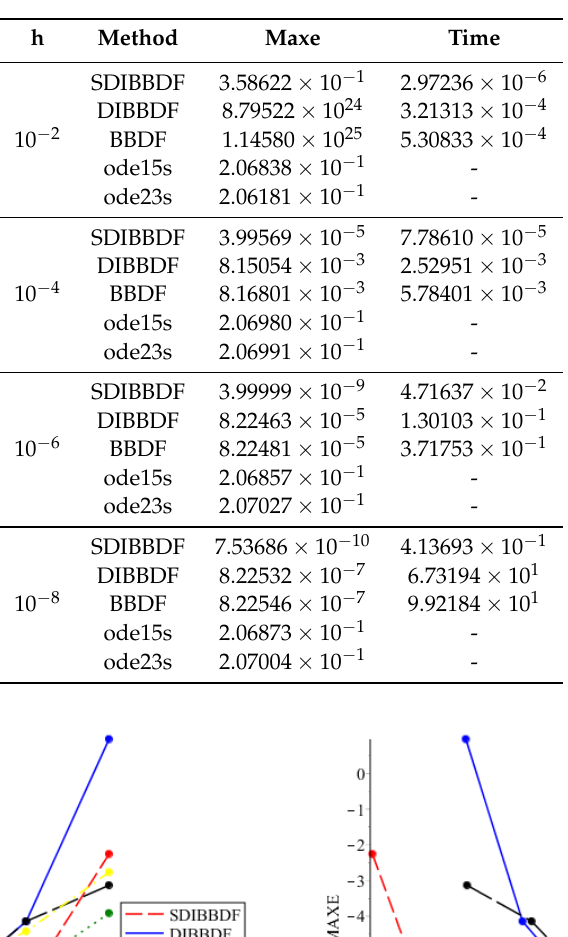
Table 6. Numerical results for test problem 5.